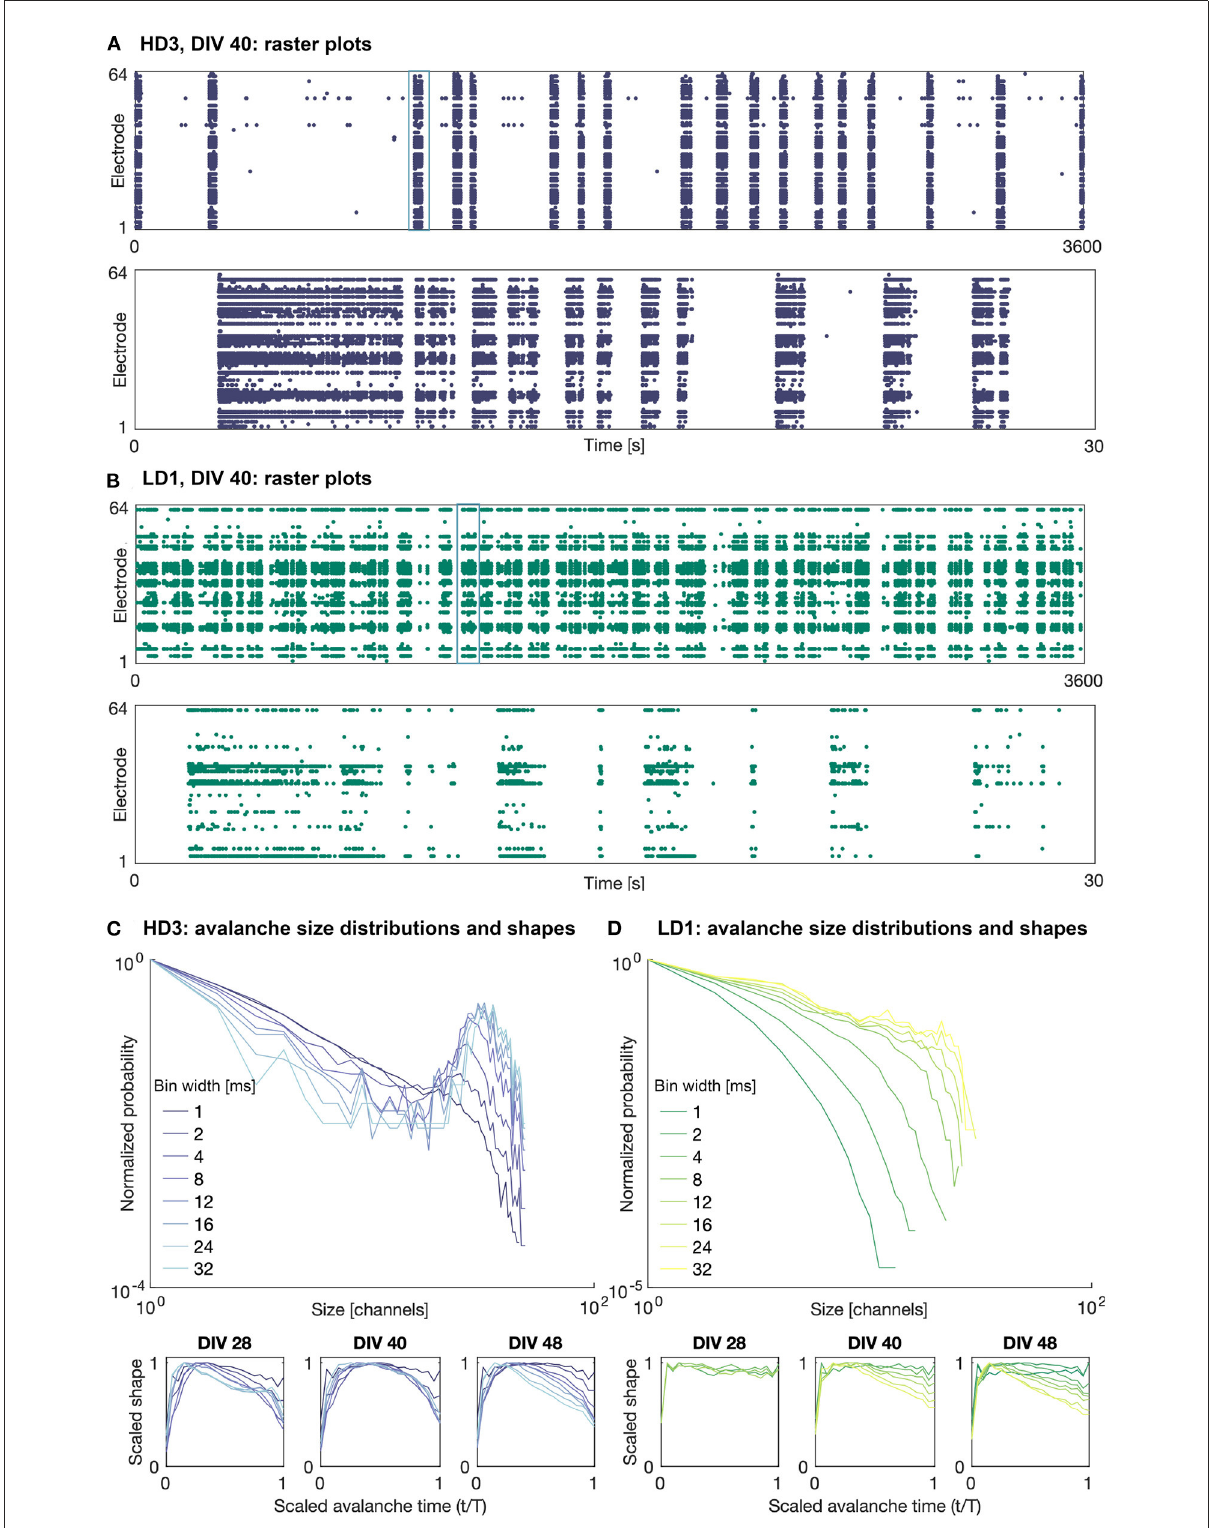
FIGURE3 Raster plots and avalanche size distributions on DIV 40. Raster plots of the entire 1 h recording period (upper) and indicated 30 s period (lower) for (A) HD3 and (B) LD1. Avalanche size distributions and mean scaled shapes obtained with different time bin widths for (C) HD3 and (D) LD1. Distributions are normalized by the probability of size